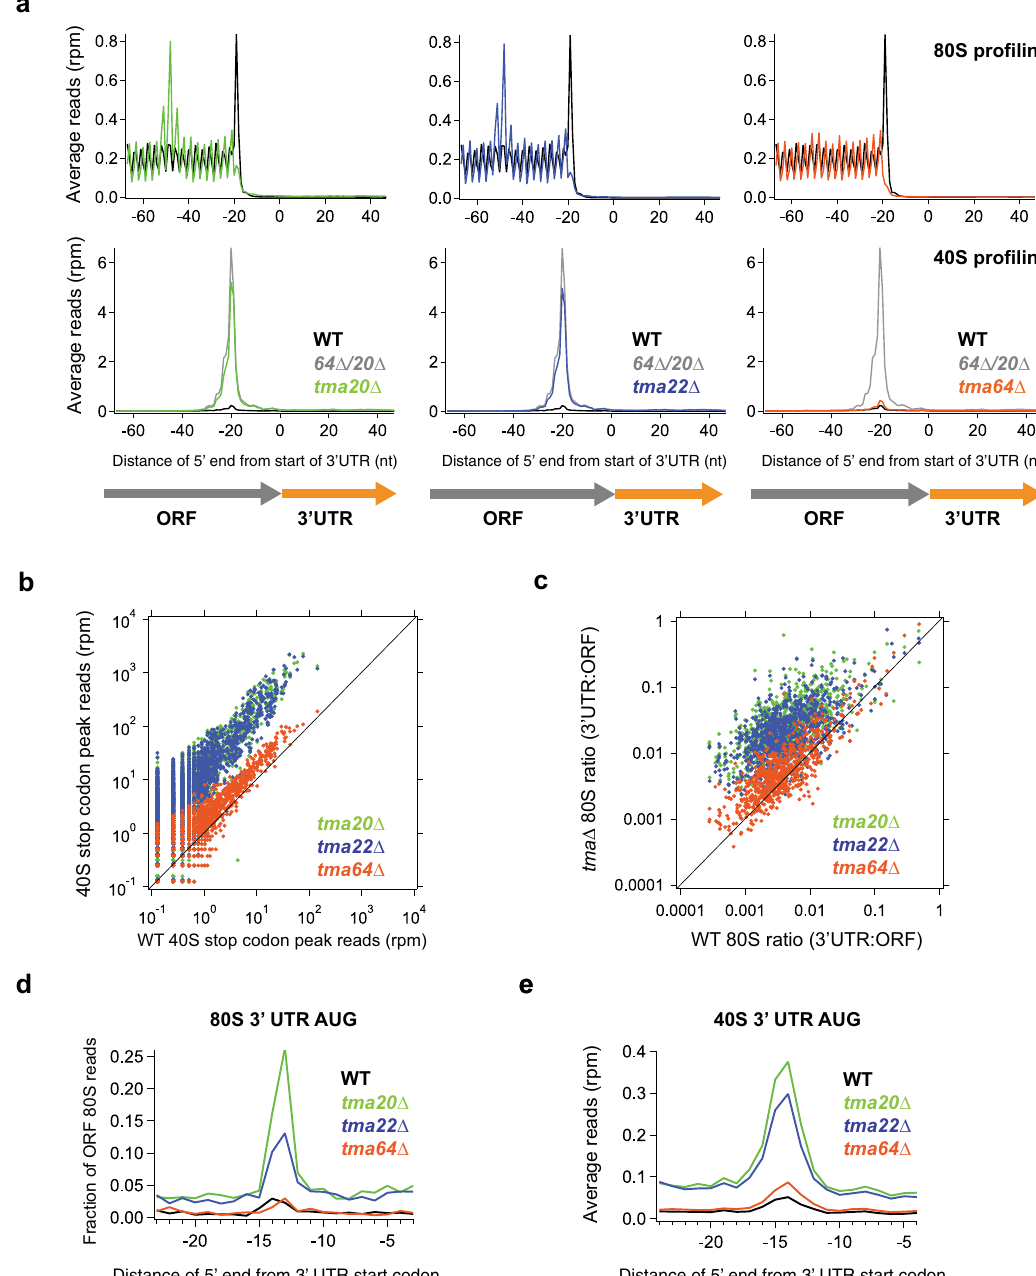
Fig. 6 Tma20 and Tma22 are responsible for the majority of 40S recycling at stop codons. a Average 80S (top) and 40S (bottom) ribosome footprint occupancy across all genes aligned at their stop codons for the tma20 Δ (left), tma22 Δ (middle), and tma64 Δ (right) strains. The data reveal a queued 80S peak one footprint length behind the stop codon (top) and increased 40S peak on the stop codon (bottom) in the tma20 Δ and tma22 Δ strains. These trends are much smaller in the tma64 Δ strain. Footprints plotted by 5 ′ ends. b Analysis of 40S stop codon peak heights (total count of footprints at the stop codon) showing a strong increase in stop codon peak height in the tma20 Δ and tma22 Δ strains (dots above the diagonal) but only a small shift in the tma64 Δ strain, compared to WT. The lack of outliers indicates the step in 40S recycling slowed by loss of the Tma proteins is also slow in WT cells. Each point represents the data for one gene. Footprint reads were quantitated by shifting them by 14 nt and then counting reads around the stop codon. c Ratio of 80S footprint density in 3 ′ UTRs to their respective ORFs is plotted for the individual tma deletion vs WT cells. Each point represents the data for one gene. The data are consistent with increased 3 ′ UTR 80S ribosome occupancy for most genes in the tma20 Δ and tma22 Δ strains (most dots are above the diagonal) but only a small shift in the tma64 Δ strain, compared to WT. d Average fraction of 80S ribosome occupancy in a window surrounding 3 ′ UTR AUG codons (in all frames) normalized to ORF ribosome density level. e Average 40S ribosome occupancy in a window surrounding 3 ′ UTR AUG codons. A peak above background level is evident for the tma20 Δ and tma22 Δ strains on AUG codons, consistent with the mechanism of 40S reinitiation. nt nucleotide, rpm reads per million, ORF open reading frame. Source data are provided as a Source Data fi le. See also Supplementary Fig.